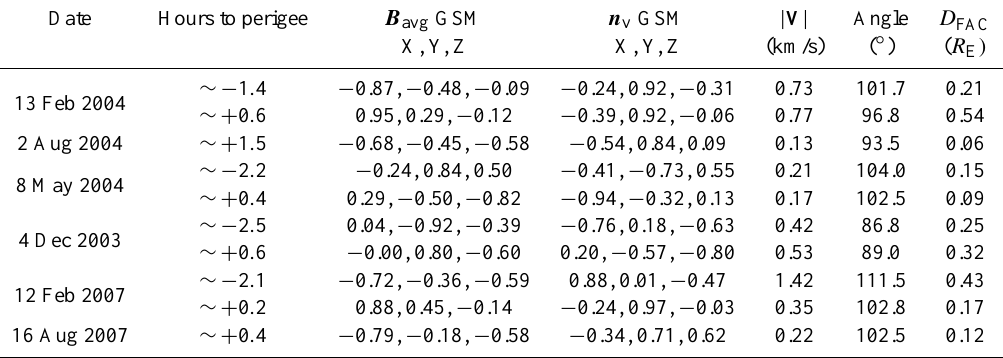
Table 2. Catalogue of the average magnetic field and FACs motion for the FACs observed by Cluster spacecraft in the orbit shown in Fig. 1, together with the angle between the average magnetic field and the FACs motion. The directions ( n v ) and the speeds ( | V | ) of the motion are obtained from four-spacecraft techniques, and the size ( D FAC ) of each FAC observed by Cluster was estimated by using the velocity and the duration of the whole bipolar signature of each